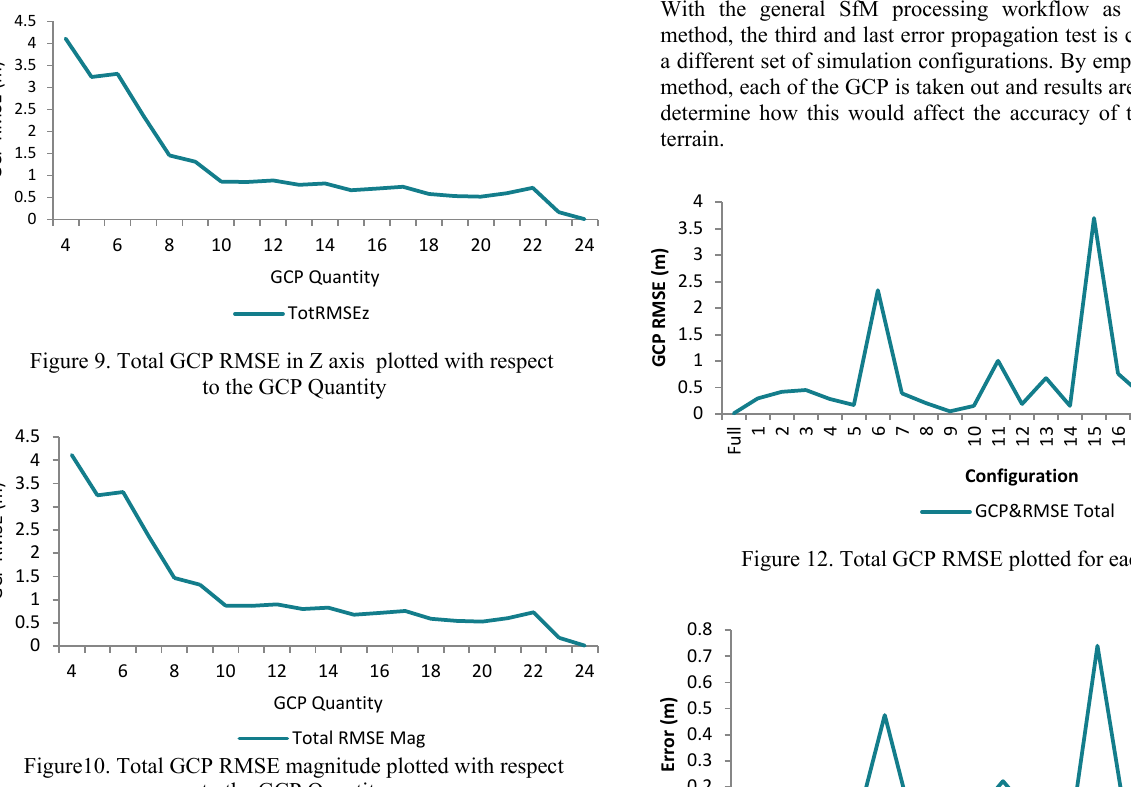
Figure 8. Total GCP RMSE in X-Y axis plotted with respect to the GCP Quantity